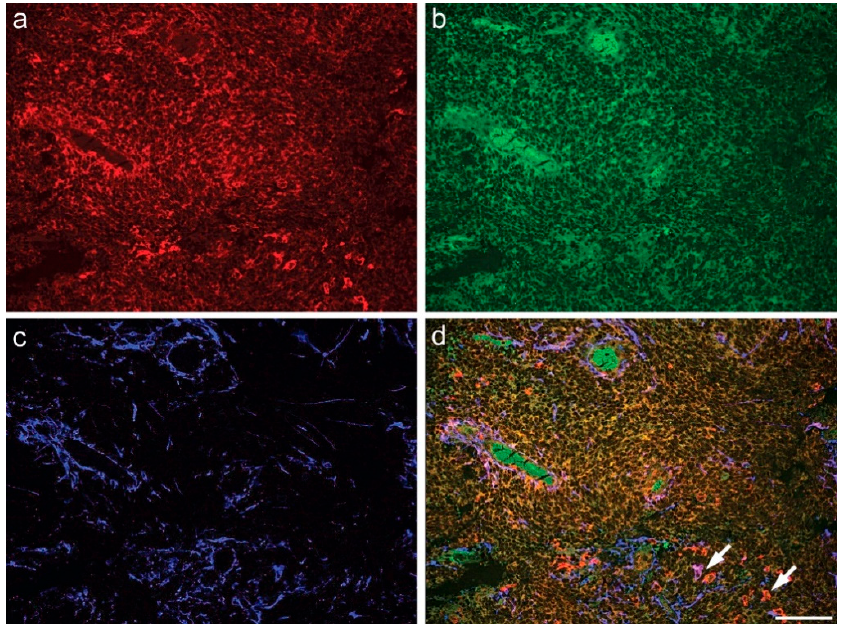
Figure 5. Coexpression of IDH1R132H and SOAT1 in an IDH1-mutated astrocytoma, CNS WHO grade 4 (arrows): ( a ) SOAT1; ( b ) IDH1 R132H; ( c ) Solanum tuberosum lectin (STL), predominantly revealing endothelia; ( d ) merge (scale bar 200 µm).